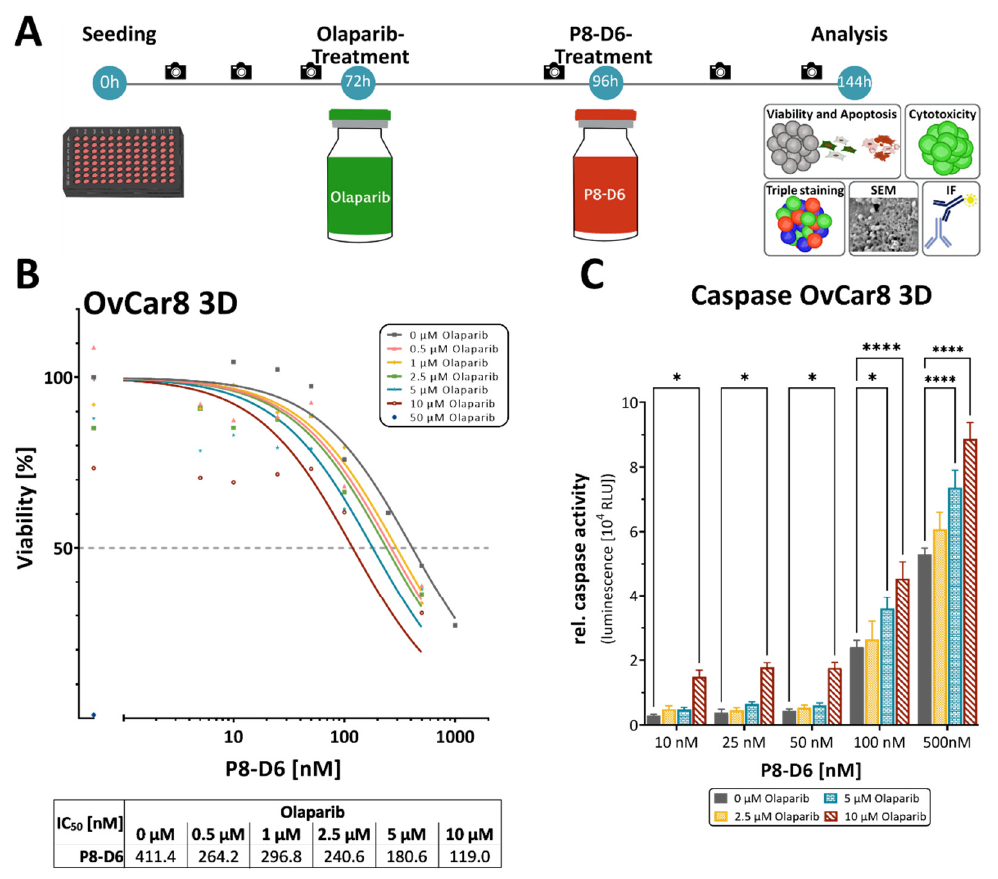
Figure 4. Anti-tumor responses in combined treatment of P8-D6 and olaparib in 3D culture. OvCar8 spheroids were maintained in ULA plates for 72 h and subsequently treated with olaparib and P8-D6 in single or combination treatment as illustrated in the schedule. ( A ) Treatment schedule. Camera visualizes the measurement time points by microscope. Subsequently, the viability and caspase activity were measured. ( B ) The IC 50 value of each olaparib concentration was calculated using the viability data. ( C ) The apoptosis is represented as relative caspase activity. Data are means + SEM one-way ANOVA, * ( p < 0.05), **** ( p <